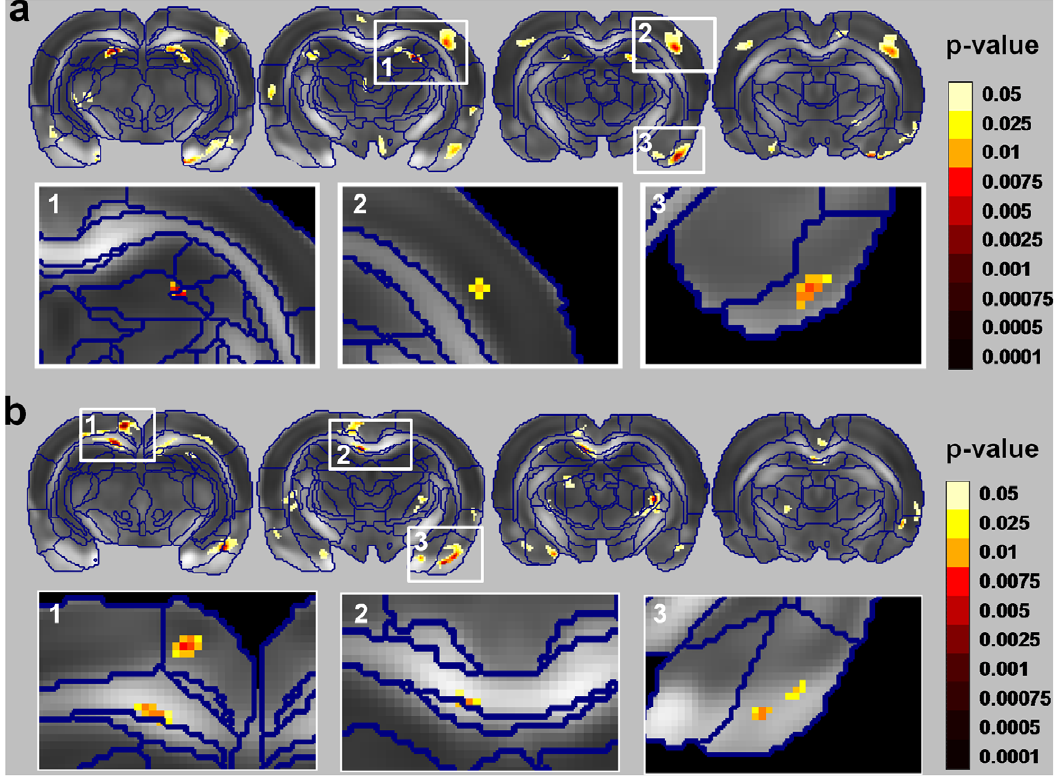
Figure 1. Statistical parametric maps of the interactions between scan time and study group [learning (L), swimming only (S) and nonlearning (NL)] for (a) the apparent diffusion coefficient (ADC) and (b) the fractional anisotropy (FA). The statistical maps (colored regions) are superimposed on an averaged FA map of all rats that were scanned, with borders of the different anatomical regions outlined in blue (see Methods). Voxels that exceed a statistical threshold of P , 0.05 (non-corrected) are colored according to the threshold they exceeded (see color scale), while those that did not exceed the threshold are not colored. We report only on regional clusters that exceeded a statistical threshold of P , 0.05 corrected for multiple comparisons; these regions are shown in the insets. These regions include the dentate gyrus (DG), piriform cortex (PC), and S1/S2 cortex (SC) in the ADC maps ( a ), and the corpus callosum (CC) and PC in the FA maps ( b ).